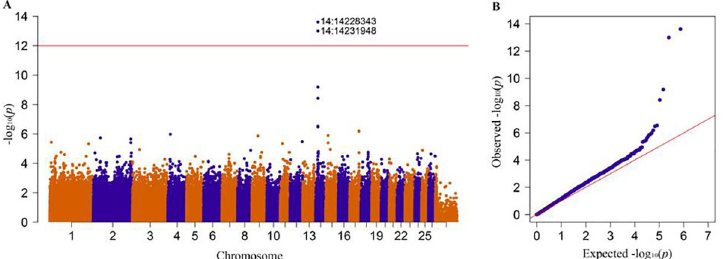
Fig 3. GWAS results plotted using Manhattan and quantile-quantile plots. (A) Manhattan plot for coat colour analysis. The horizontal red line denotes genome-wide significance (1e -12) . The y-axis shows the -log 10 ( p ) value, and the x-axis shows the chromosome number. (B) QQ plot: the -log10 (P-value) shows the normality of the observed (y- axis) and expected (x-axis) values. The red line shows a normal curve, -and blue indicates colour variation among individuals. The two blue dots on the top denote significant SNPs for the coat colour